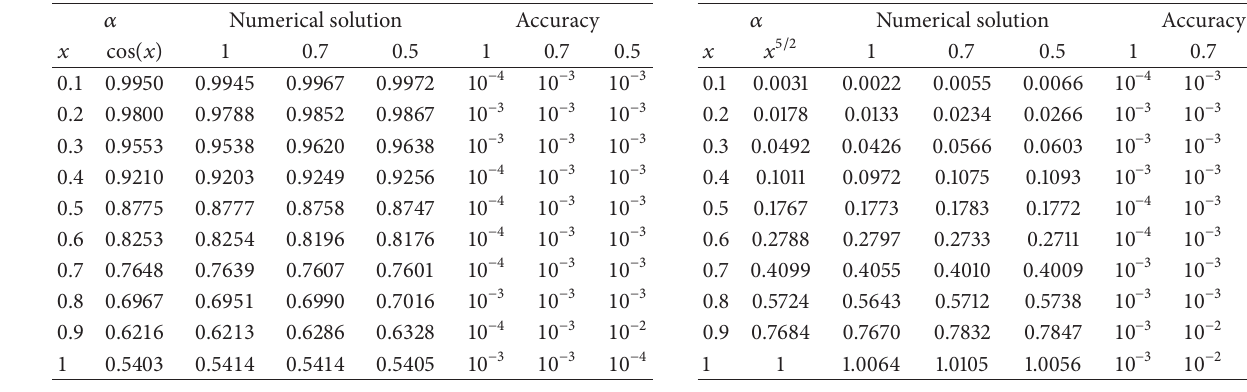
Table 4: Exact solution, approximate solution, and accuracy for Example 3